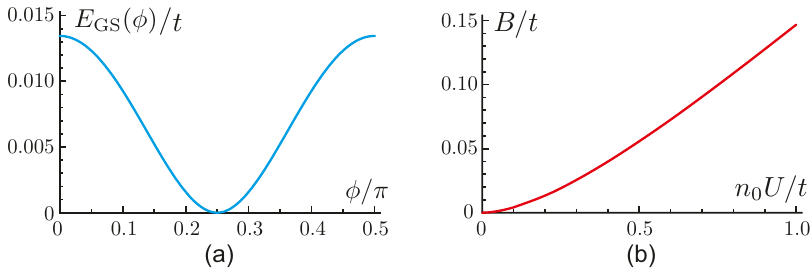
Figure 3 . (a) The quantum ground-state energy E GS ( φ ) has a minimum at φ = π/ 4 . Expanding around the minimum leads to the coefficient B in (b), which is a monotonically increasing function of the interaction strength. In order to clearly see the OFQD, we subtract E GS by it minimum min φ E GS . The parameters are n 0 U = t = 1